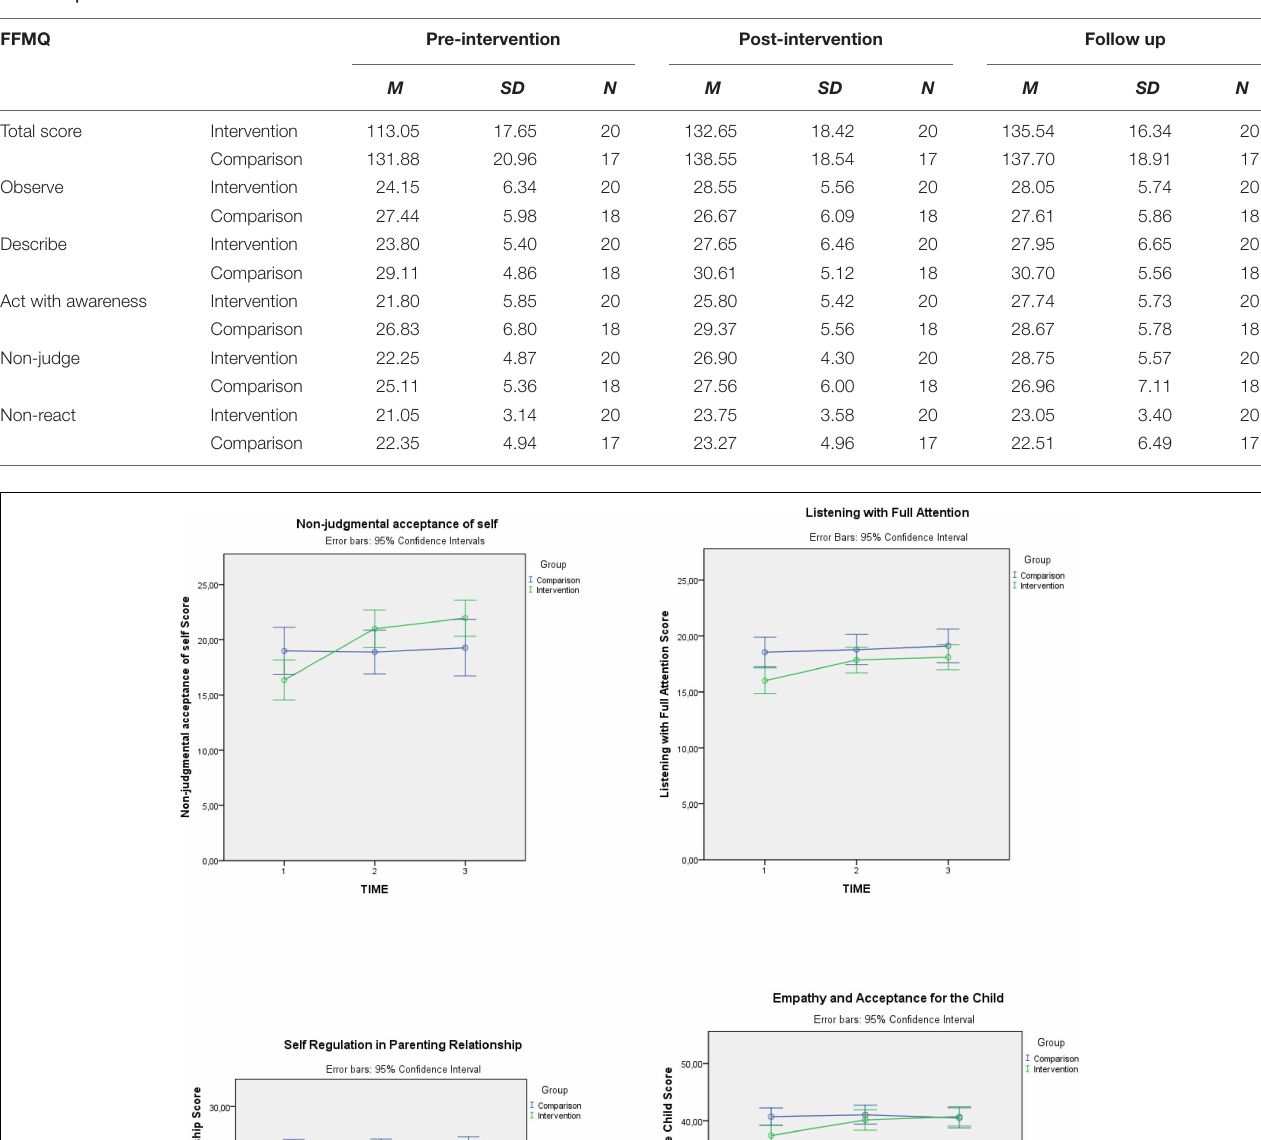
TABLE 4 | FFMQ means and standard deviation scores.